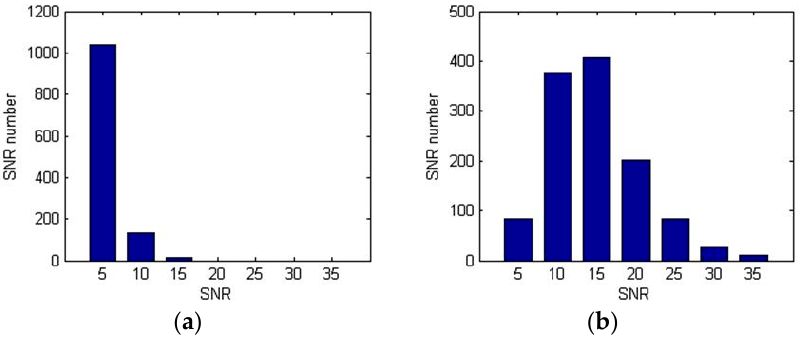
Figure 13. Distribution of SNR ( dt = 1/10 s, T = 20.0 s, time = 11:10–11:50). ( a ) ExPRO; and ( b ) MuPRO.